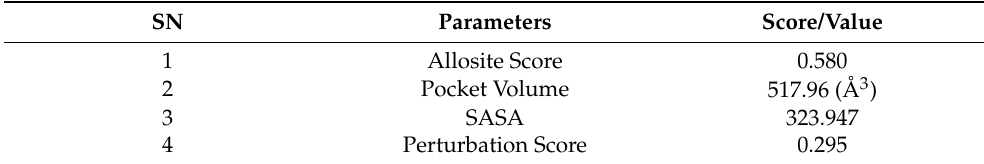
Table 1. SARS-CoV-2 MTase allosteric site parameters.